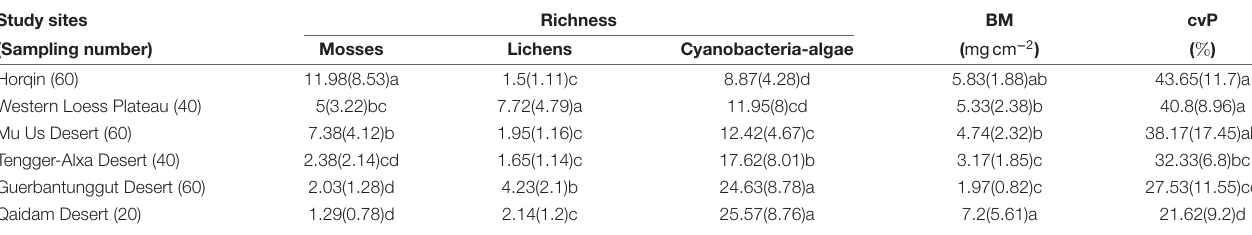
TABLE 2 | Biotic indicators include the richness of mosses, lichens, and cyanobacteria-algae, the biomass of biocrusts, and the cover of perennial plants of the study sites (mean (SD)) in northern Chinese deserts. Study